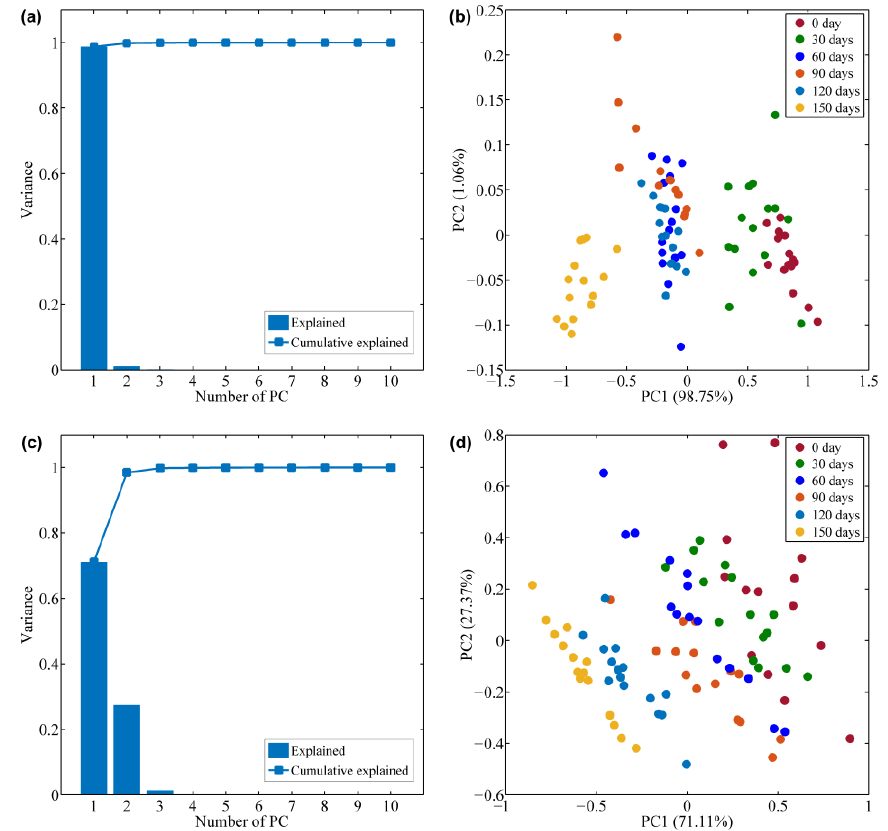
Figure 2. Explained and cumulative explained variance by PCA based on measured fatty acids ( a ) and spectral data ( c ). PCA score plots of tea samples with different storage duration based on measured fatty acids ( b ) and spectral data ( d ).